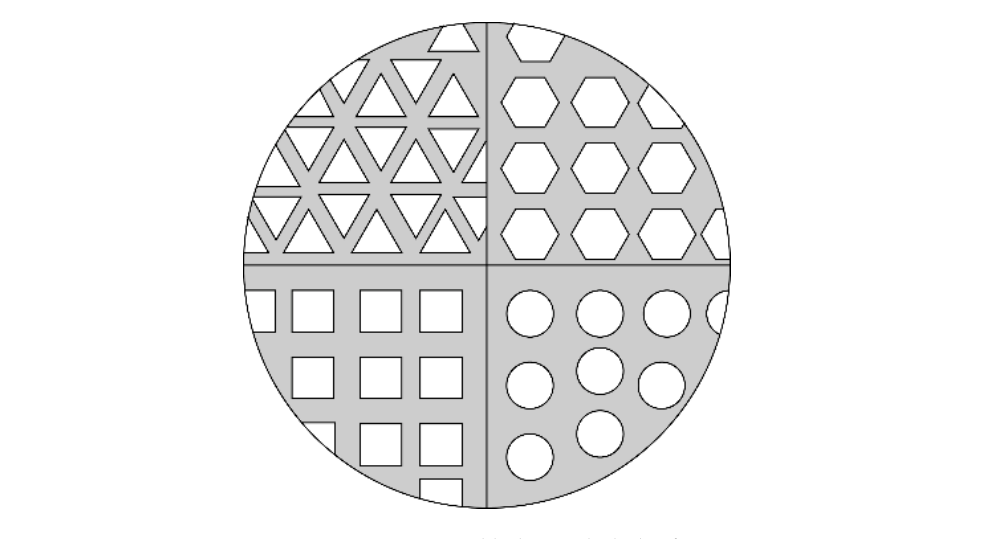
Figure 13. Quintessential lightweight holes for mirrors. Table 5. Performance comparison of lightweight holes.